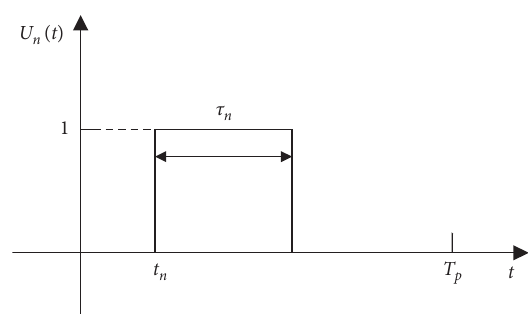
Figure 2: Rectangular pulse switching function.